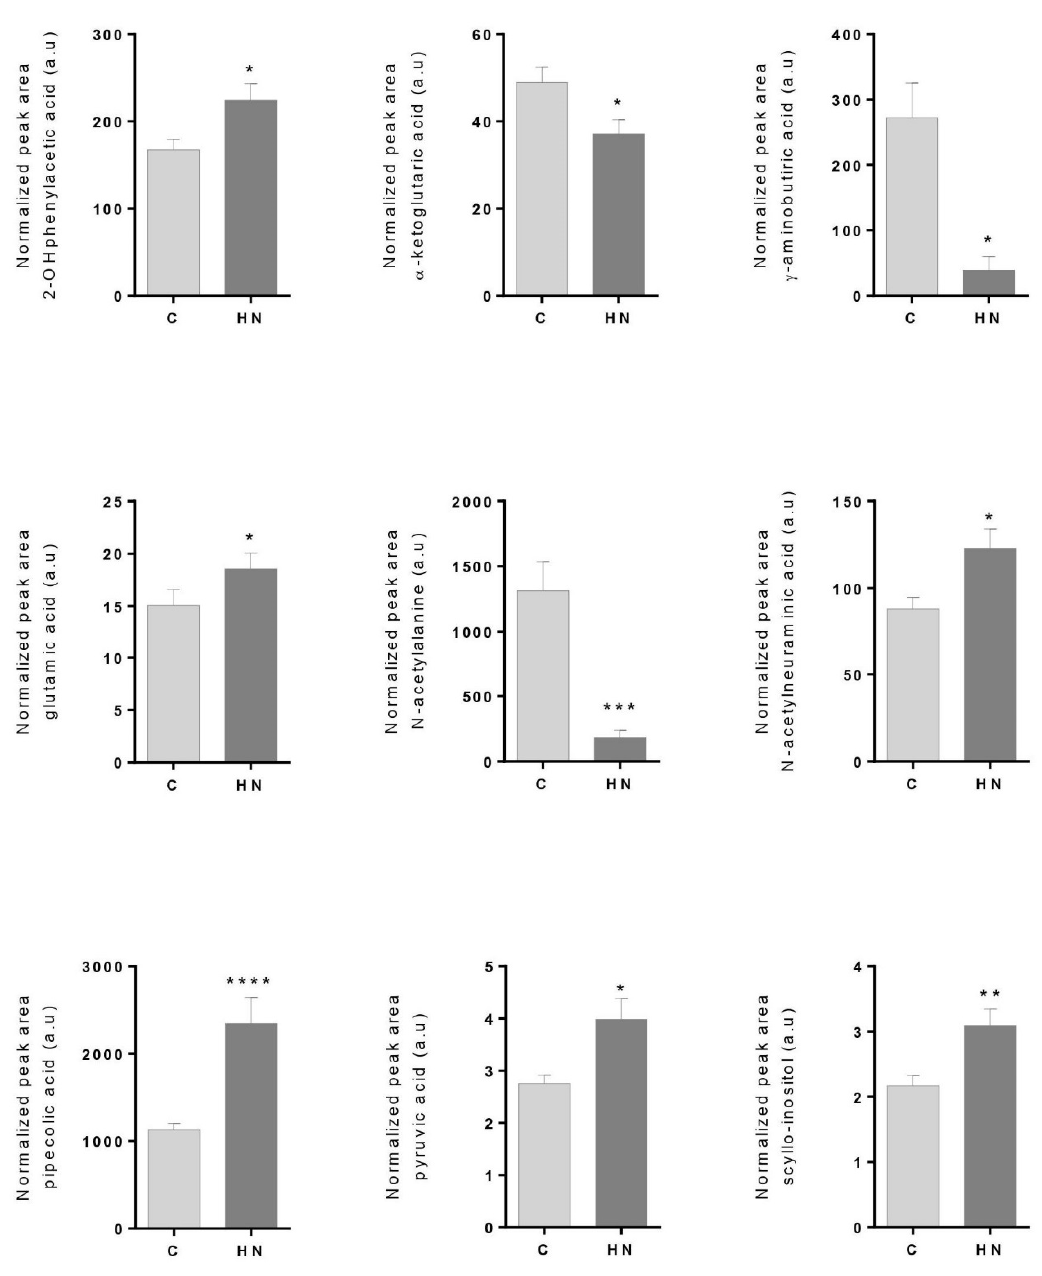
Figure 1. Metabolites showing significantly altered levels in urine between control subjects (C; ACR < 10 mg/g) and sub- jects in the high–normal range (HN; ACR = 10–30 mg/g). Error bars show standard error media. A Mann–Whitney non-parametric test (95% confidence level) was performed (* p value < 0.05, ** p value < 0.01, *** p value < 0.001, **** p value < 0.0001). Exact p values were 0.0142 (2-hydroxyphenylacetic acid), 0.0116 ( α -ketoglutaric acid), 0.0173 (GABA), 0.0238 (glutamic acid), 0.0006 (N-acetylalanine), 0.0204 (N-acetylneuraminic acid), <0.0001 (pipecolic acid), 0.0138 (pyruvic acid) and 0.0036 (scyllo-inositol).